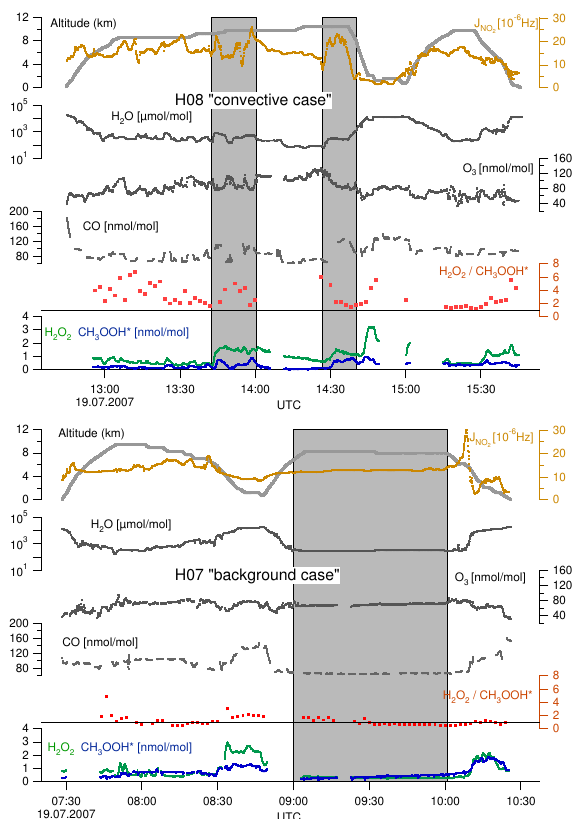
Fig. 14. The usage of the H 2 O 2 /CH 3 OOH ∗ ratio as indicator for re- cent convective influence on an airmass. Time series of HOOVER flights 07 and 08 representing the “convective” (H 08) and “back- ground” (H 07) case. The peroxide ratio is in the range of 2–4 over- all for flight H 08, and the effect of convective injection can be seen in the grey shaded boxes in CO, water vapour and enhanced perox- ide levels in the upper troposphere. In contrast, the grey shaded box during flight 07 shows a chemically aged airmass with low and flat time series for CO, O 3 , water vapour and peroxide but nevertheless shows peroxide ratios around and even below unity.